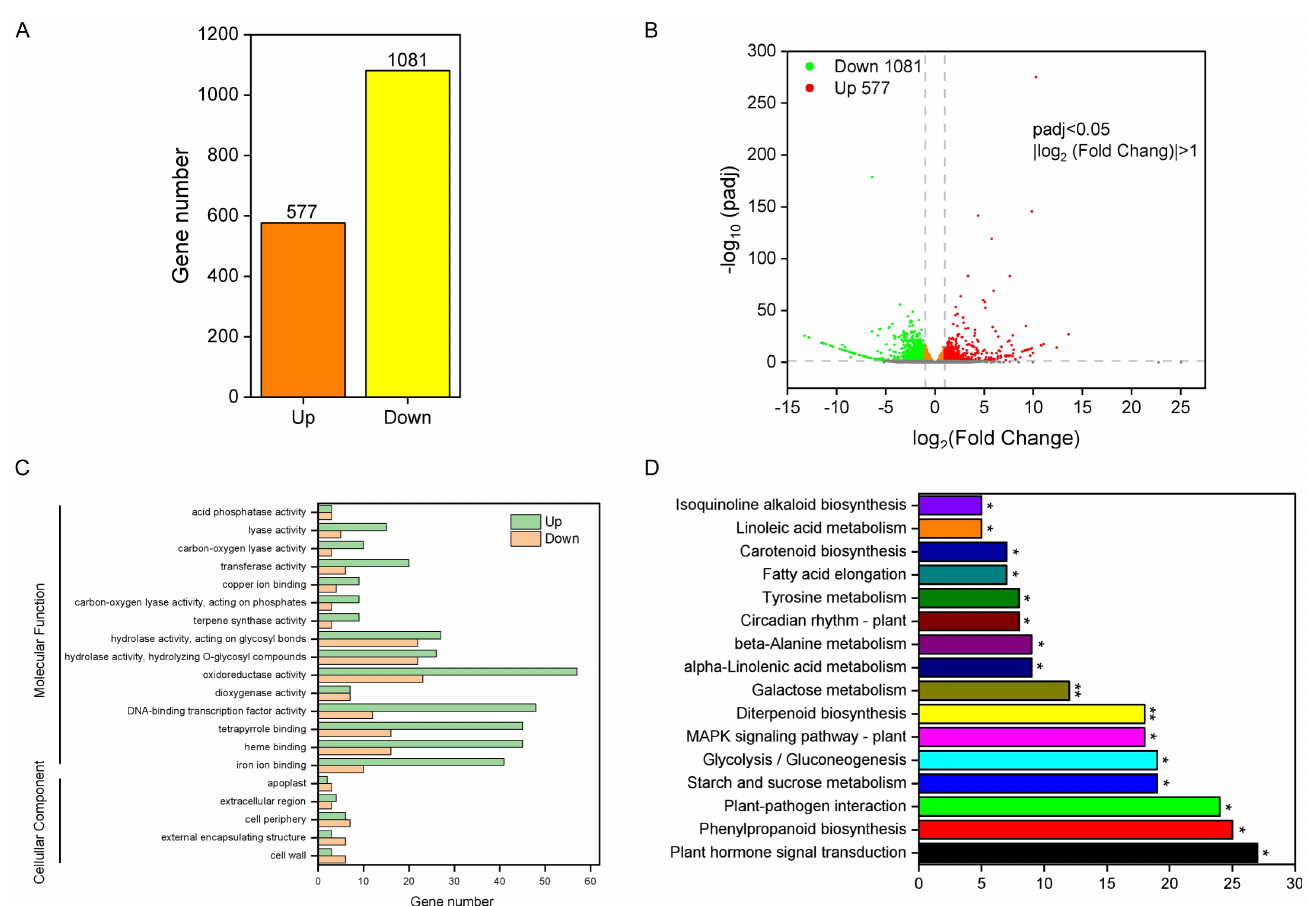
Figure 2. Transcriptome analysis of IL and ZH11. ( A ) The number of up- and down-regulated genes (padj < 0.05) in the seeds following six hours of imbibition of IL compared with ZH11. ( B ) Volcano plot of DEGs between IL and ZH11. ( C ) Go analysis of DEGs (padj < 0.05), divided into cellular composition and molecular function. ( D ) KEGG pathway enrichment analysis of DEGs. The data represent the mean ± SD ( n = 3), * p ≤ 0.05 and ** p ≤ 0.01.